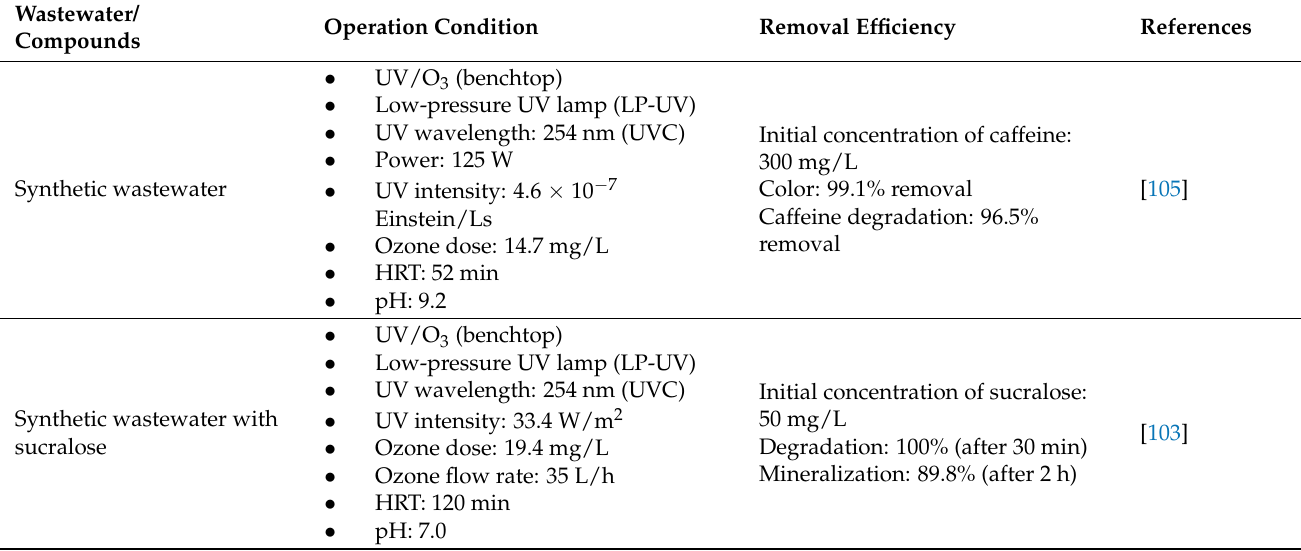
Table 5. Current application of UV/Ozone